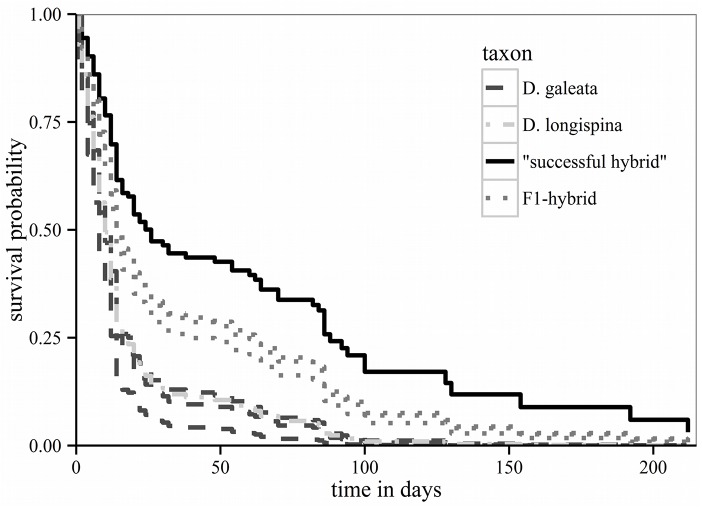
Winter experiment.Predicted survival curves estimated in the Cox regression model for each clone over time. The “successful hybrid” is represented by a solid line. Other hybrid clones are represented by dotted lines, species clones are indicated by dashed lines. The “successful hybrid” shows the highest survival probability followed by F1-hybrids and parental species.